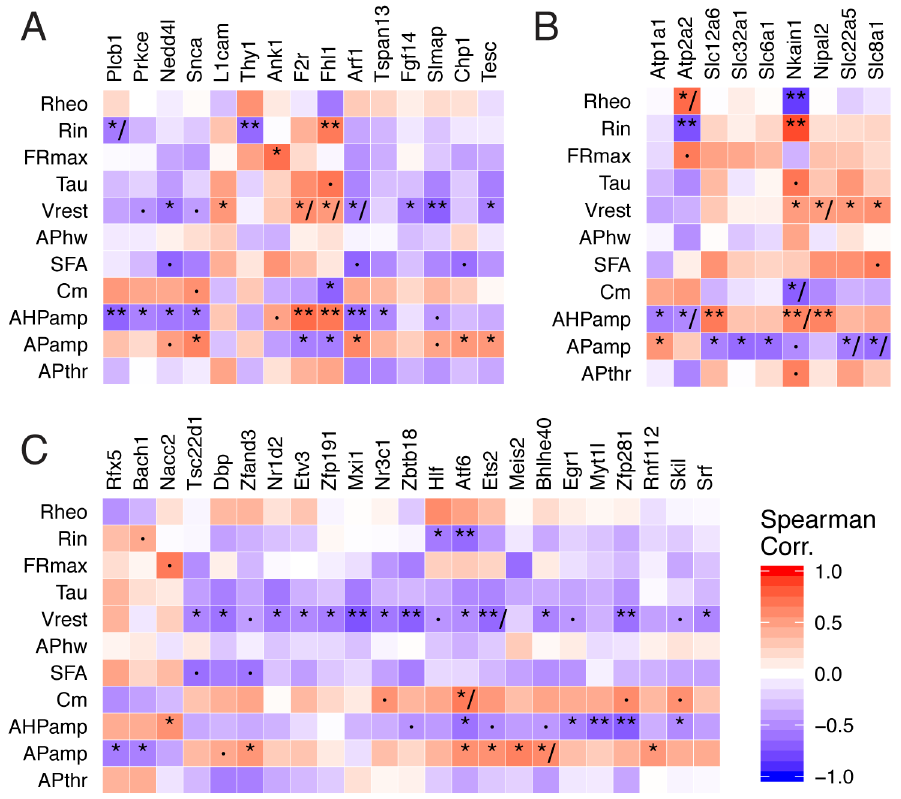
Fig 5. Summary of gene-ephys correlations for selected functional gene sets. A) Genes regulatingion channels and transporter function. B) Ion transporters. C) Transcription factors. Genes filtered for those with at least one statisticallysignificantcorrelationwith an ephys property(p adj < 0.05) and validatingin AIBS dataset. Symbols within heatmap: (cid:1) , p adj < 0.1; * , p adj < 0.05; ** , p adj < 0.01; /, indicatesinconsistency between discoveryand AIBS